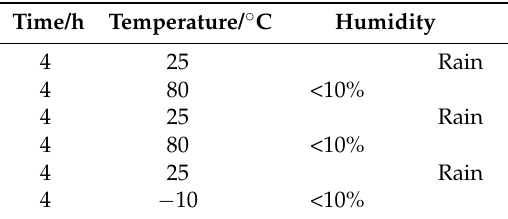
Table 2. Weathering exposure cycle. Continuous UV irradiation at 40 W/m 2